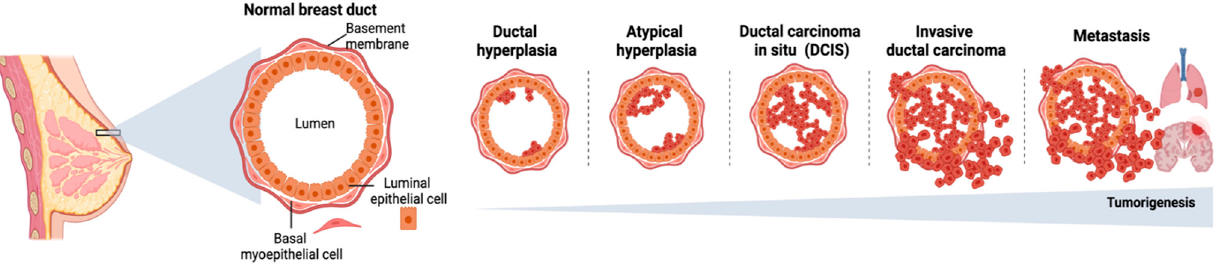
Figure 2. Subsequent steps of tumorigenesis in breast cancer, from ductal hyperplasia to the formation of